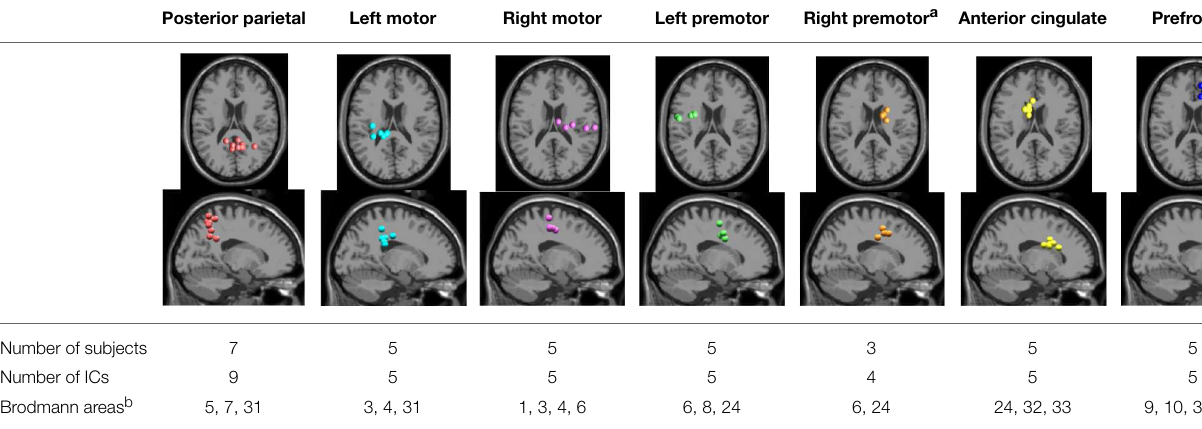
TABLE 1 | Clusters of dipolar sources fit to independent components. Posterior parietal